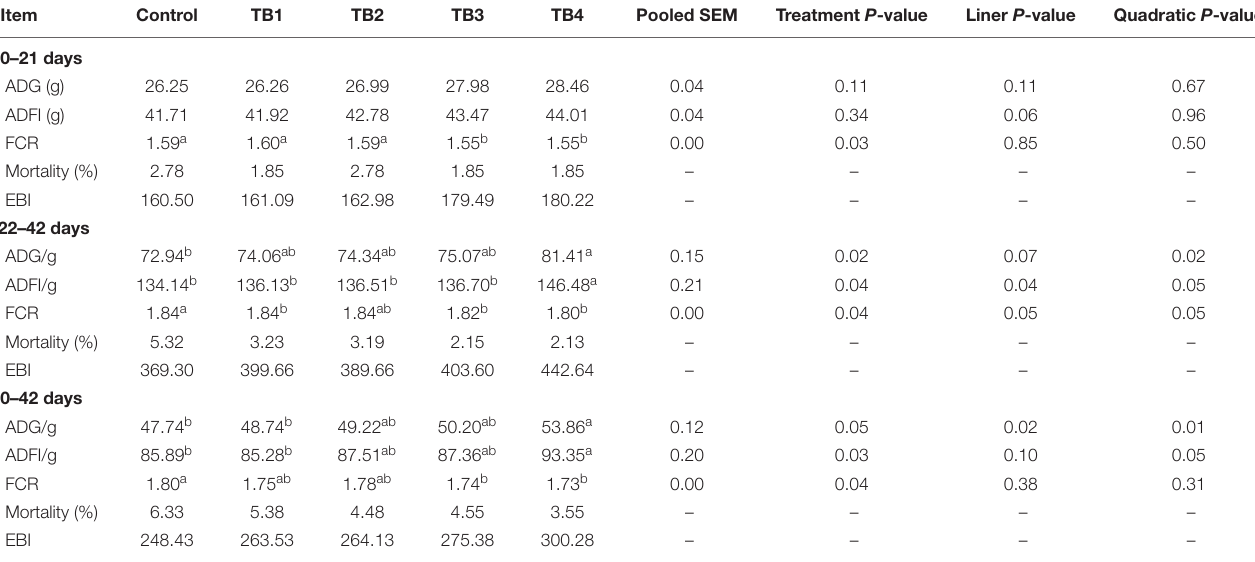
TABLE 2 | Effect of dietary TB on growth performance in broilers.